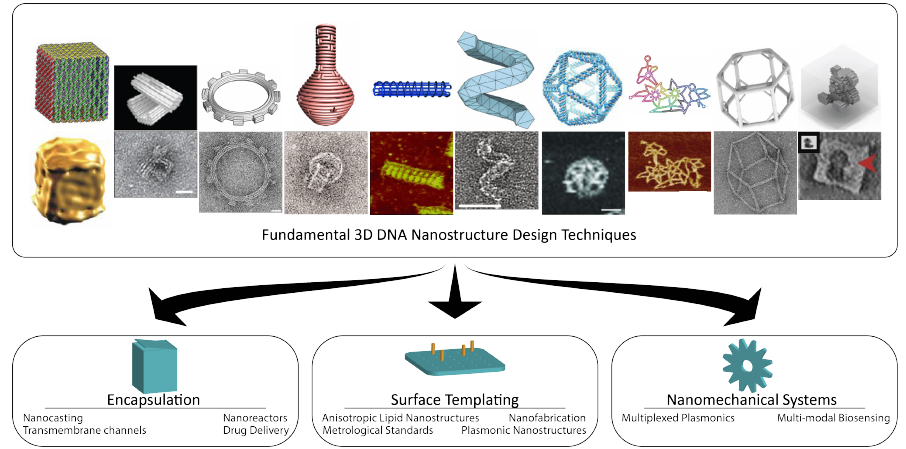
Figure 1. Mechanical designs of 3D DNA nanostructures are applied to a wide range of interdisciplinary areas through three archetypal functions of nanoscale geometric design. Fundamental design techniques of 3D DNA nanostructures (left to right): Assembly from flat shapes (reprinted with permission from Springer Nature [7]); DNA origami blocks (reprinted with permission from Springer Nature [8]); Curved and twisted DNA origami bundles (reprinted with permission from AAAS [9]); Single-layer curved DNA origami (reprinted with permission from AAAS [10]); Gridiron curved DNA origami (reprinted with permission from AAAS [11]); Polygonal DNA origami routed by an Eulerian circuit solution (Benson et al. reprinted with permission from Springer Nature [12] and Veneziano et al. reprinted with permission from AAAS [13]) or multi-arm junctions (reprinted with permission from Springer Nature [14]); Piecewise polyhedral DNA nanostructures (reprinted with permission from AAAS [15]); DNA bricks (reprinted with permission from Springer Nature [16]). Their designs can be used to encapsulate a cavity for protection or transportation of other molecules, for the arrangement or templated assembly of other molecules based on the geometric orientation provided by the DNA nanostructure, or using tunable, dynamic nanomechanical features of DNA nanostructures to measure or manipulate other